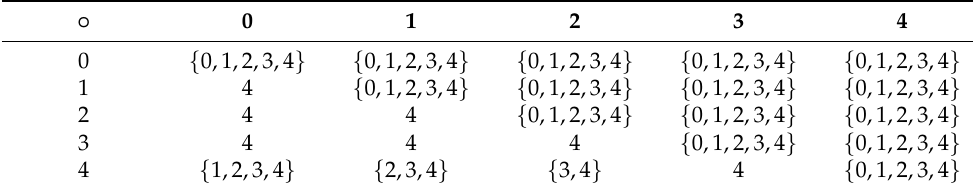
Table 13. Generalized anti-grouped quasi-hyper BZ